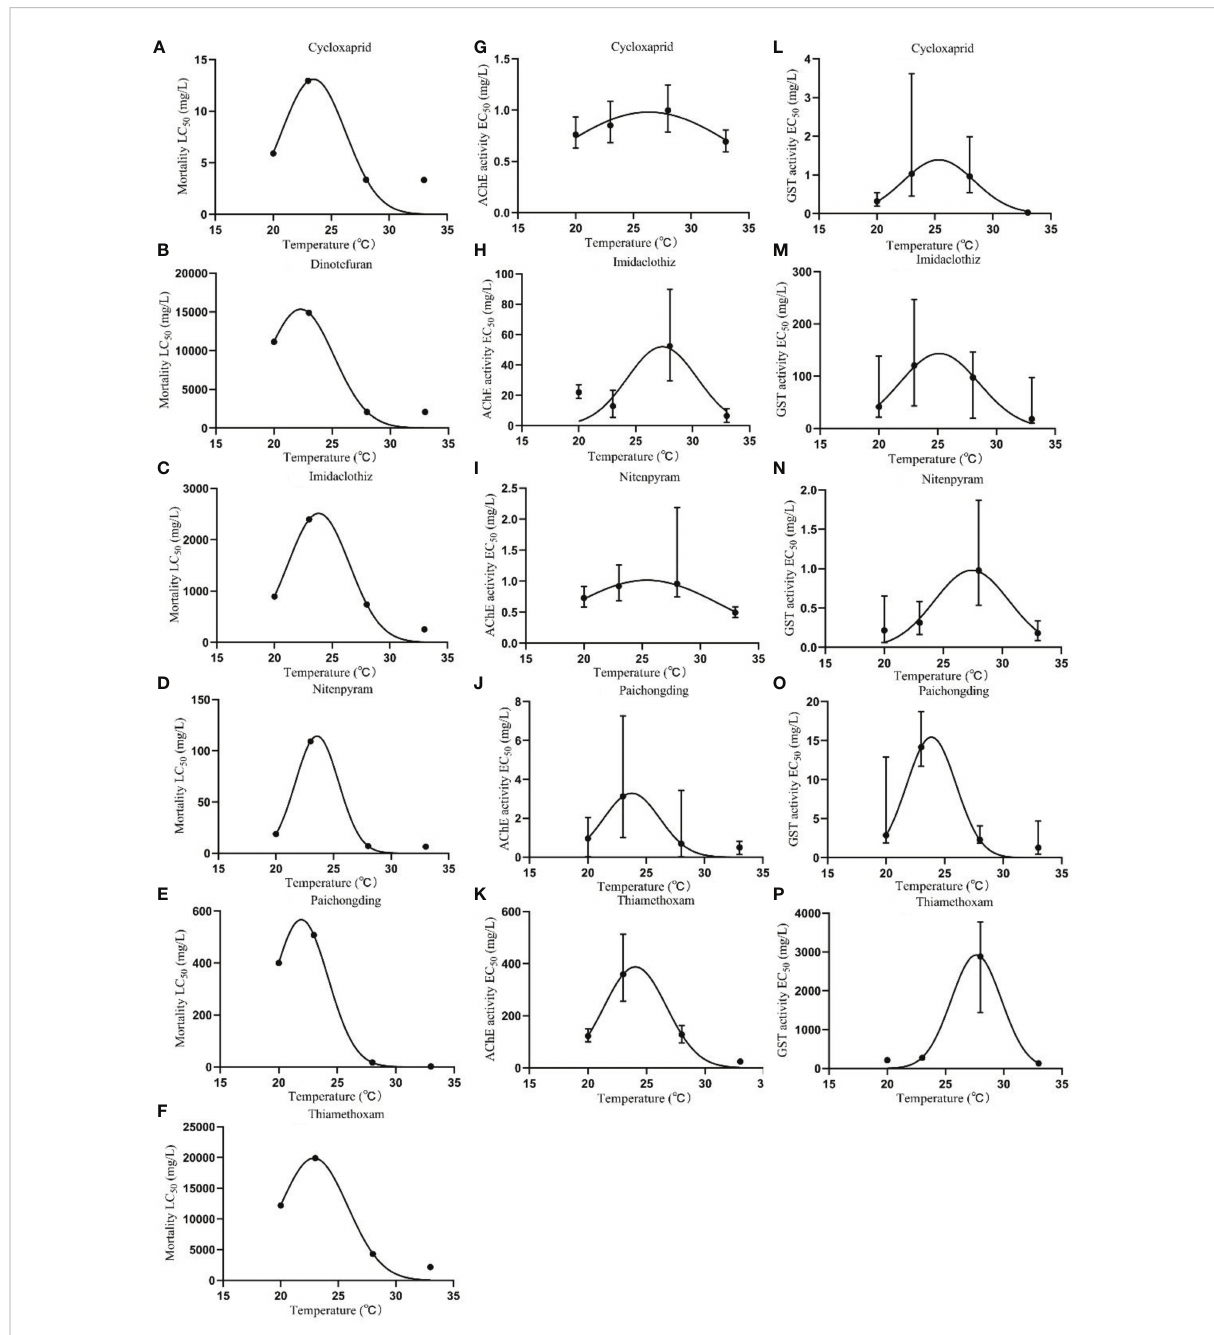
FIGURE 1 Temperature-dependent chemical toxicity of neonicotinoids to zebra fi sh embryos. (A – F) Effect of temperature on the lethal toxicity (LC 50 ). (G – K) Effect of temperature on the toxicity threshold (EC 50 ) of AChE inhibitory effect. (L – P) Effect of temperature on the toxicity threshold (EC 50 ) of glutathione S- transferase